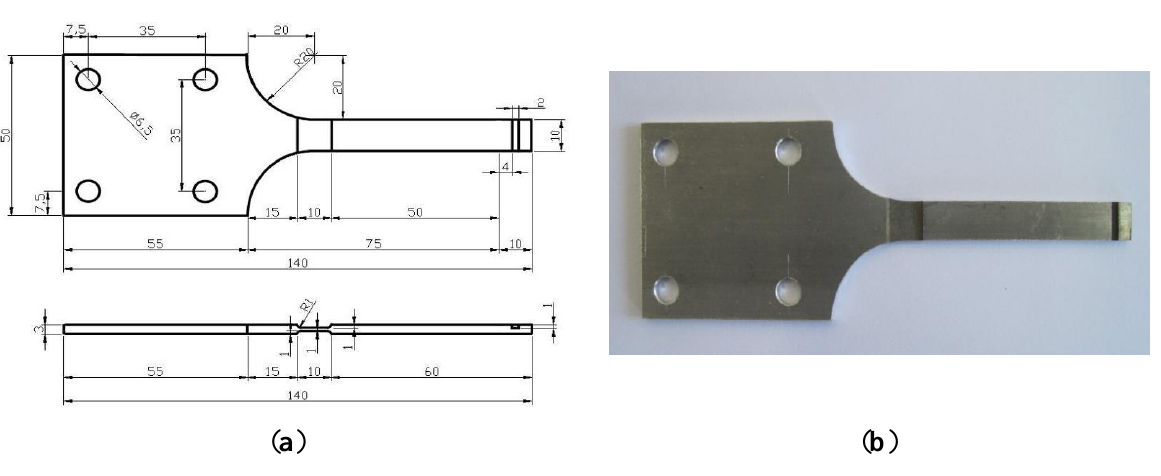
Figure 9. Design of the specimen. ( a ) Geometry parameters of the specimen (unit: mm); and ( b ) Photo of the specimen.